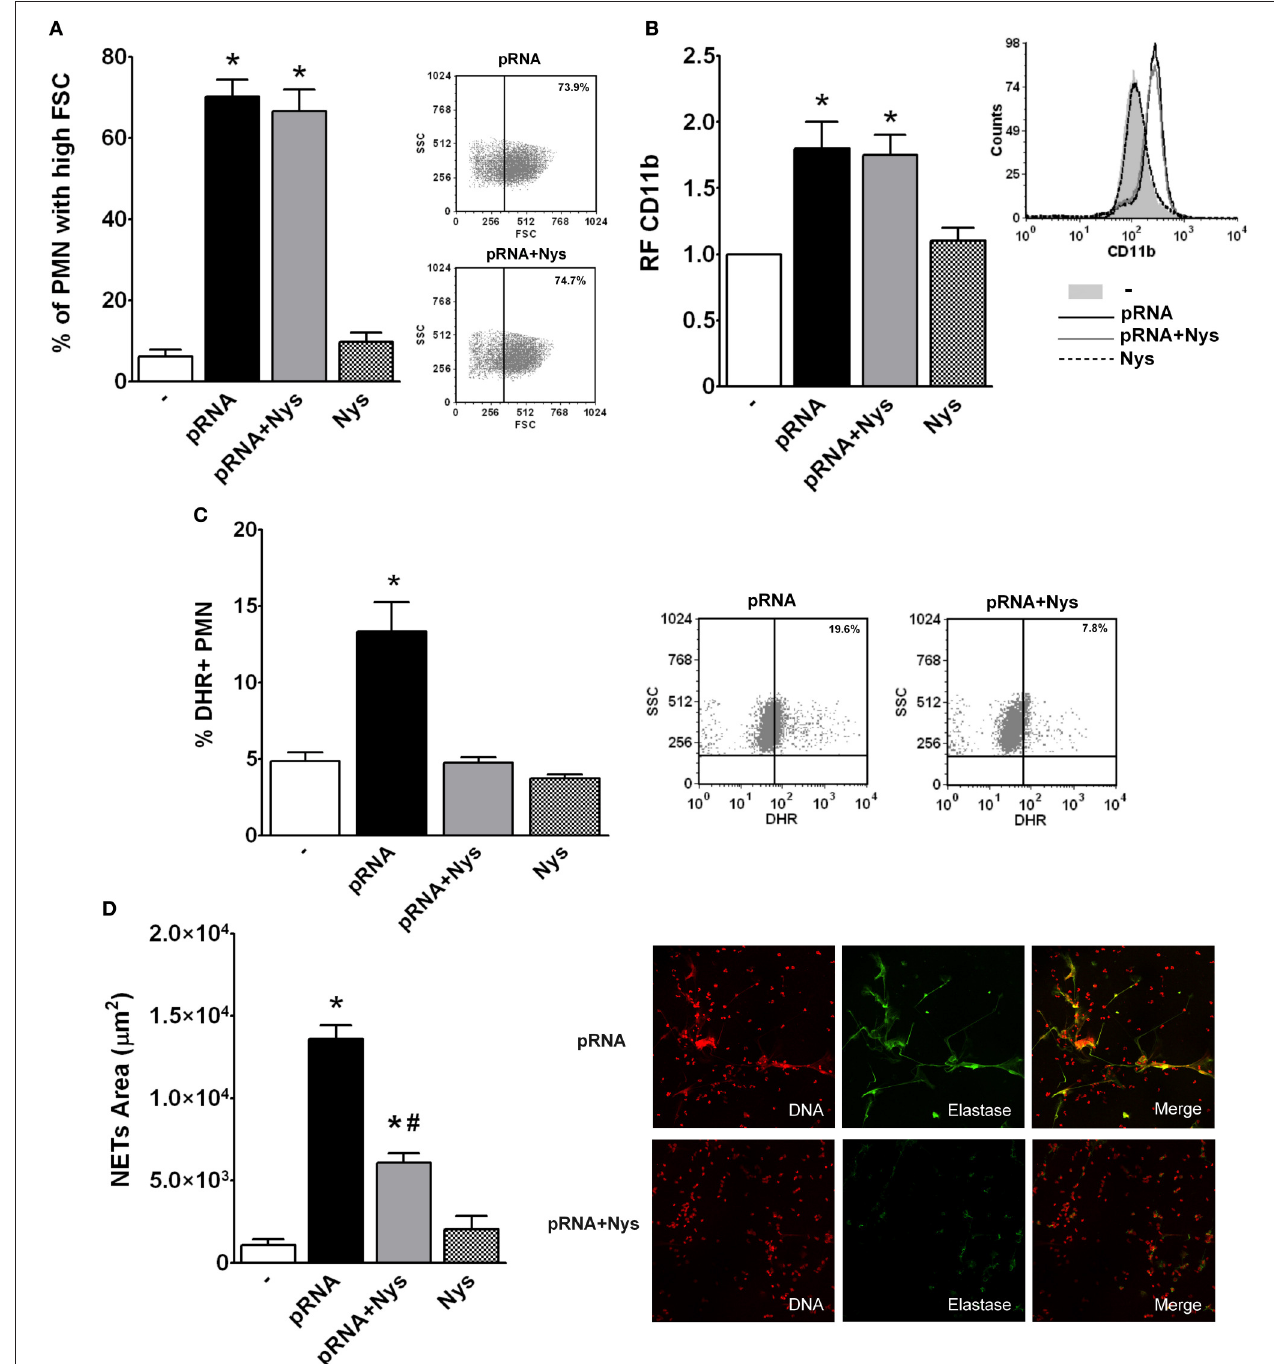
FIGURE 5 | Endocytosis of pRNA is needed for triggering bactericidal responses. Isolated PMN were incubated with pRNA in the presence or absence of the endocytosis inhibitor, Nystatin (Nys). Results were expressed as the mean ± ES, n = 5. (A) Percentage of FSC high PMN. Right panel : Representative dot-plots showing the SSC vs. FSC profiles of PMN incubated with pRNA or pRNA + Nys. (B) Expression of CD11b. Results were expressed as the relative fluorescence (RF) of the MFI of the different treatments with respect to untreated PMN. Right panel : Representative histogram showing the CD11b expression of PMN left untreated or incubated with pRNA, pRNA + Nys, and Nys. (C) ROS generation. Right panel : Representative dot-plots of the percentage of DHR + PMN are shown in untreated ( − ) or incubated with pRNA, pRNA + Nys, and Nys. (D) NETs formation. Right panel : Representative microphotographs of confocal images showing PMN from pRNA and pRNA + Nys groups stained for DNA or elastase visualization and the merge of the images (x200). In all cases * p < 0.05 vs. all other groups and # p < 0.05 vs. pRNA.